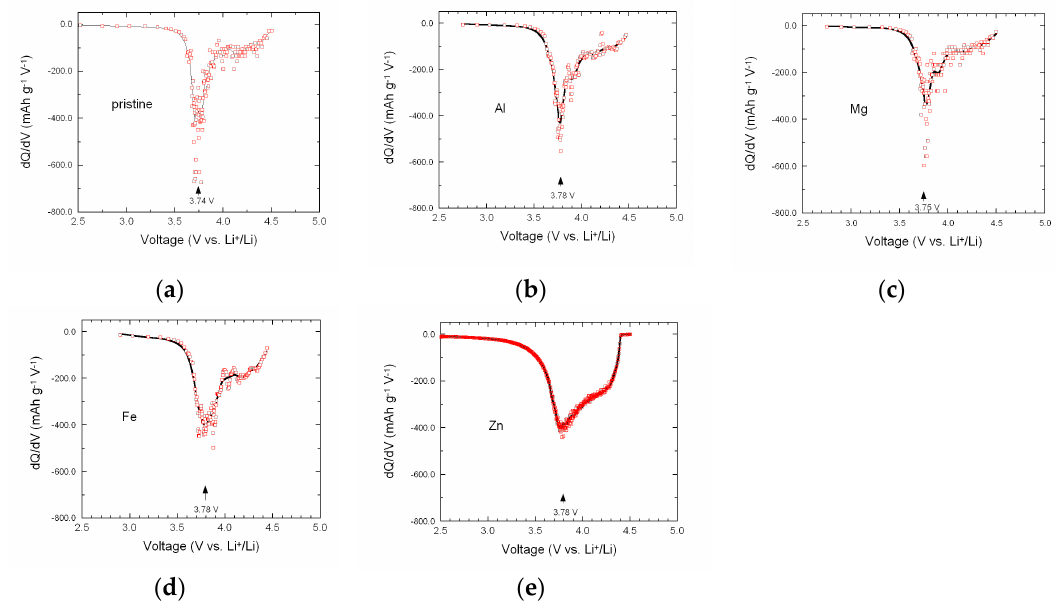
Figure 9. Differential capacity ( − d Q /d V ) plots of cycle #2 for pristine LiNi 1/3 Mn 1/3 Co 1/3 O 2 ( a ) and M ‐ doped LiNi 1/3 Mn 1/3 Co 1/3 O 2 with Al ( b ), Mg ( c ), Fe ( d ) and Zn ( e ). M -doped LiNi 1 / 3 Mn 1 / 3 Co 1 / 3 O 2 with Al ( b ), Mg ( c ), Fe ( d ) and Zn ( e ).